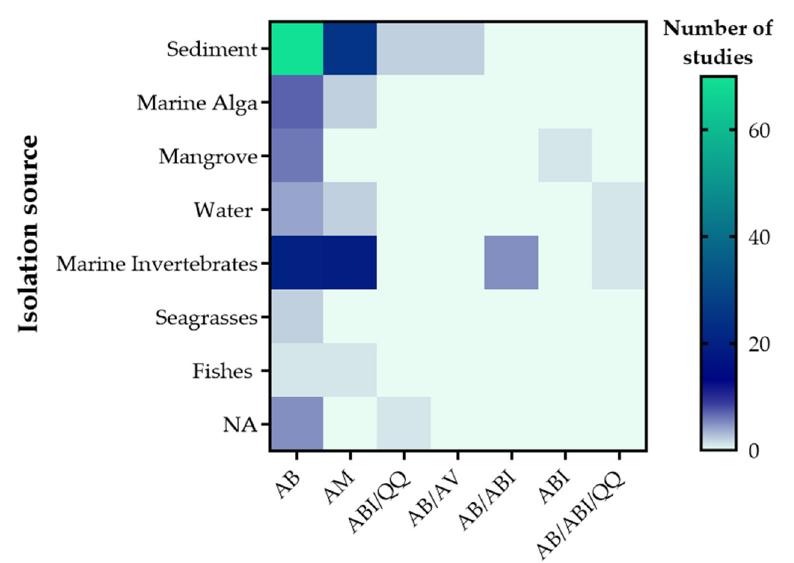
Figure 5. Heatmap of the number of articles included in this study that reported the isolation source of compounds with the biological activity of interest. Isolation sources are arranged from top to bottom, starting with the largest number at the top left. Bioactivities are shown at the bottom from left to right by the largest number of papers reported. The color bar represents the number of studies that reported the source of isolation of bioactive metabolites, from white to blue (lower values), blue to green (medium values), and green (high values). AB: antibacterial activity; AM: antimicrobial activity (activity against bacteria, fungus, parasites); ABI/QQ: antibiofilm and QQ activity; AB/AV: antibacterial and antiviral activity; AB/ABI: antibacterial and antibiofilm activity; ABI: antibiofilm; AB/ABI/QQ: antibacterial, antibiofilm and QQ activity.